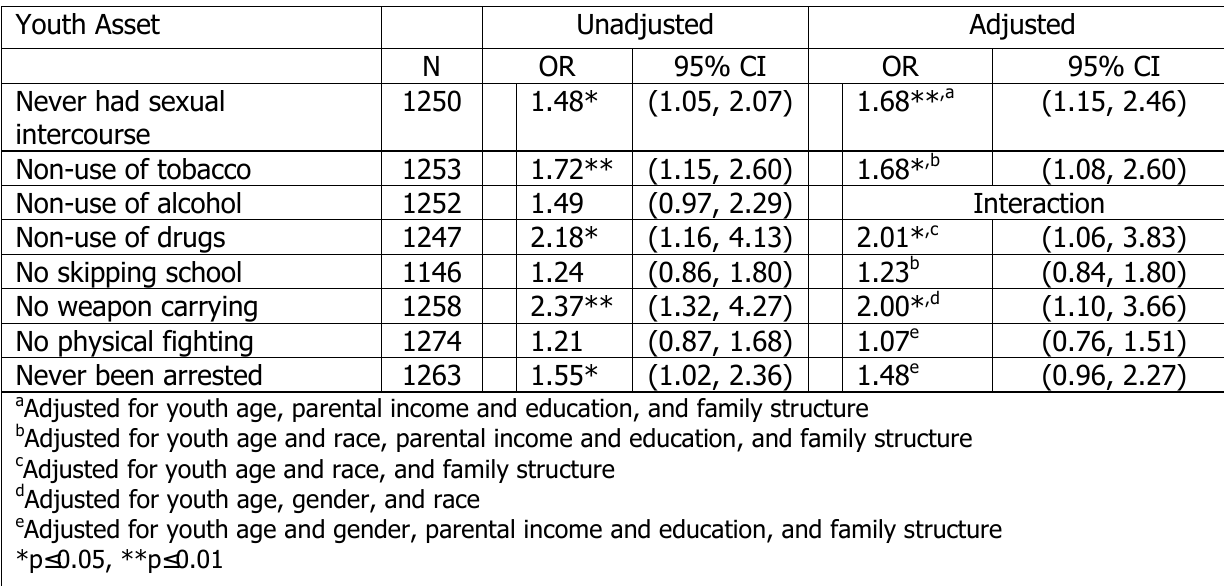
Unadjusted and Adjusted Odds Ratios (OR) with 95% Confidence Intervals (CI) from Individual Multiple Logistic Regression Models for Community Involvement on Various Risk Behaviors